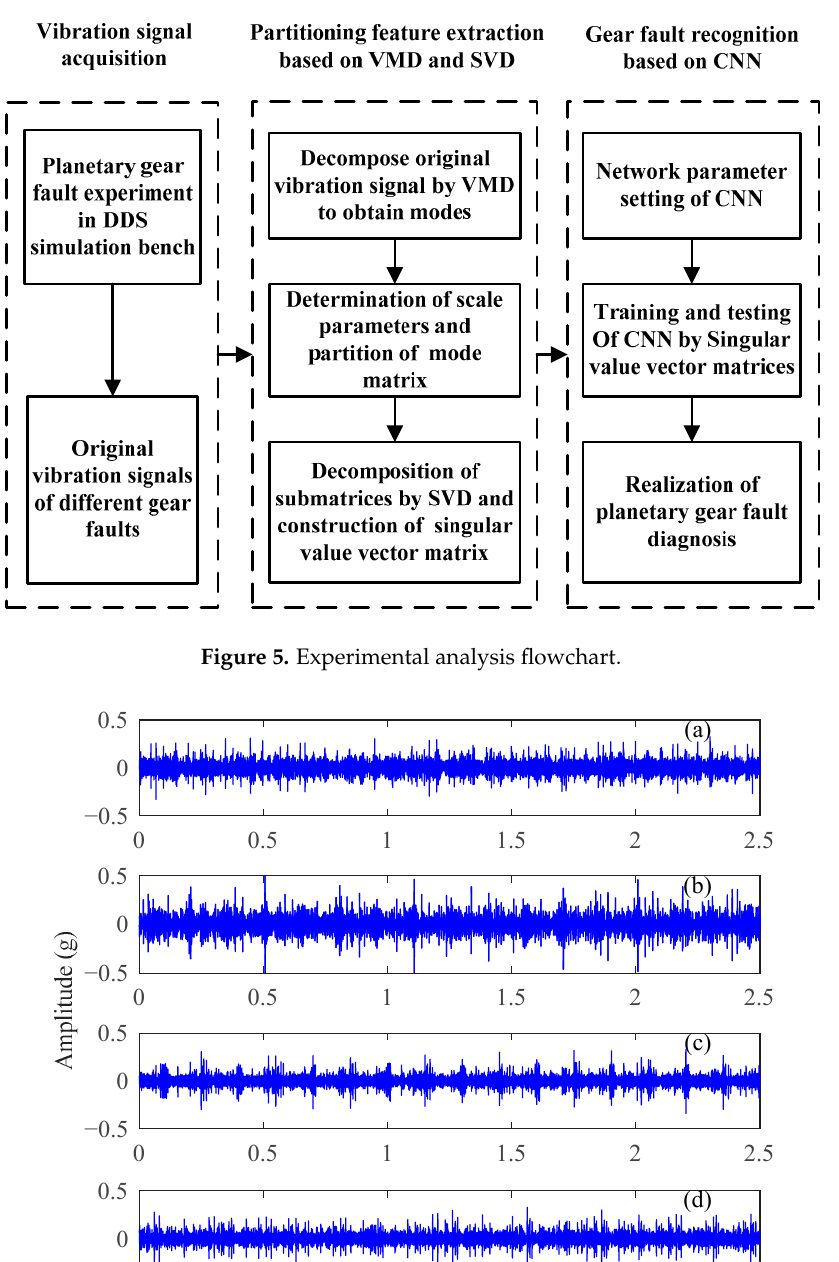
Figure 6. Time-domain vibration signals of the planetary gears: ( a ) normal gear, ( b ) gear with wear, ( c ) gear with breakage, and ( d ) gear with root crack tooth.